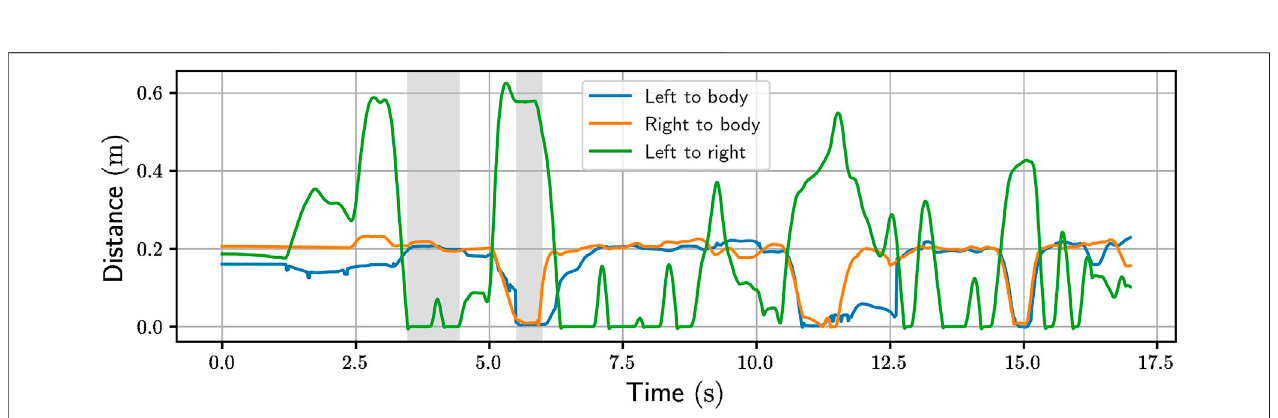
FIGURE4| VisualizationofthedigitaltwinofthePARTIsysteminMuJoCo(left)andthecoupledrealhardware(right)duringthe fi rstexperiment,wheretheoperator actively attempts to bring the system into collision. The additional collision meshes around the end effectors to facilitate the collision avoidance behavior are seen in red.